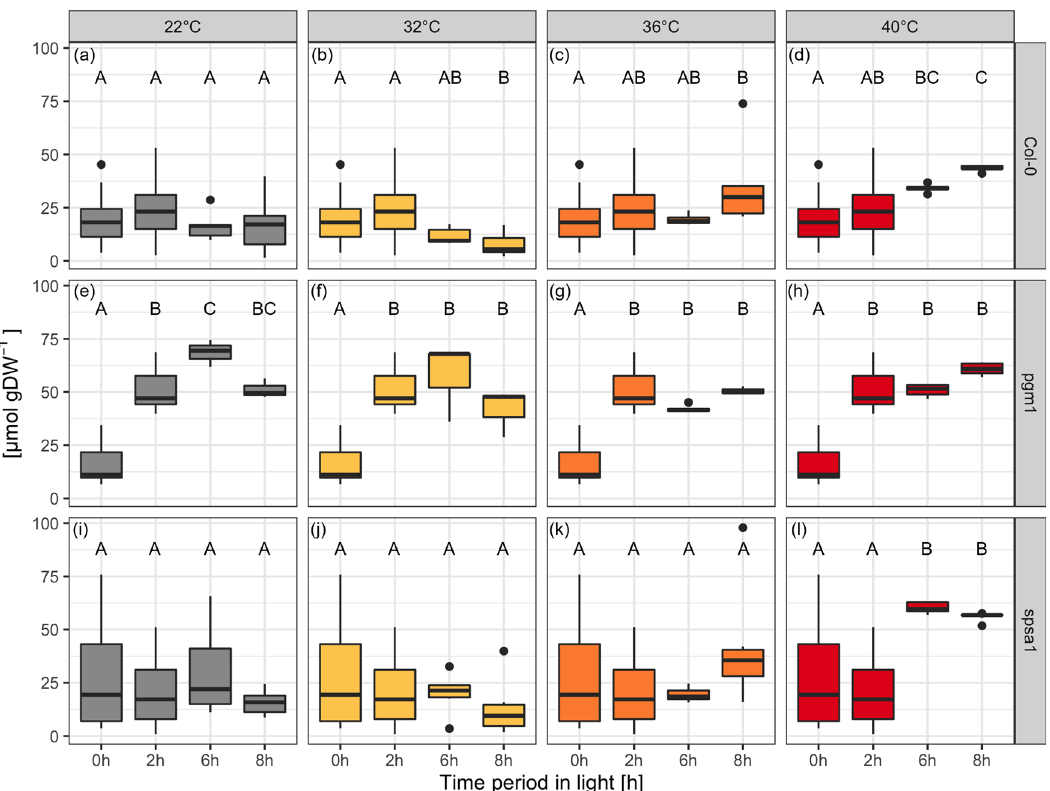
Fig. 6 Sucrose concentrations during short-day transient heat exposure. a – d Col-0 ( n ≥ 5); e – h pgm1 ( n ≥ 3); i – l spsa1 ( n ≥ 5). Gray: 22 °C experiment; yellow: 32 °C experiment; orange: 36 °C experiment; red: 40 °C experiment. The temperature was set to 22 °C between 0 – 2 h and 6 – 8 h. The temperature was transiently increased between 2 and 6 h. Box-and-whisker plots: center line, median; box limits, upper and lower quartiles; whiskers, 1.5× interquartile range; points, outliers. Capital letters indicate groups of signi fi cance within genotype and condition (ANOVA, P < 0.05). Experimental data are provided in Supplementary Data